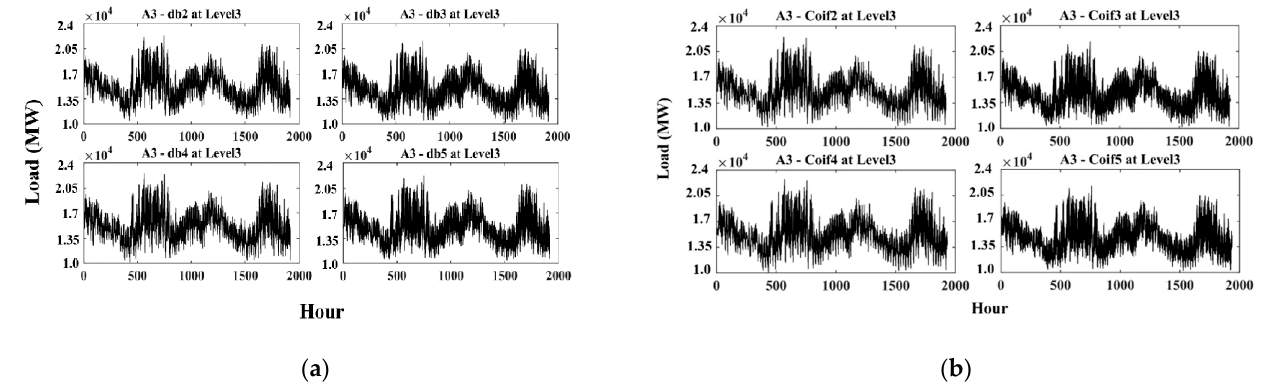
Figure 4. Wavelet approximation coefficients at different levels: ( a ) db family approximation coeffi- cients; ( b ) coif family approximation coefficients .